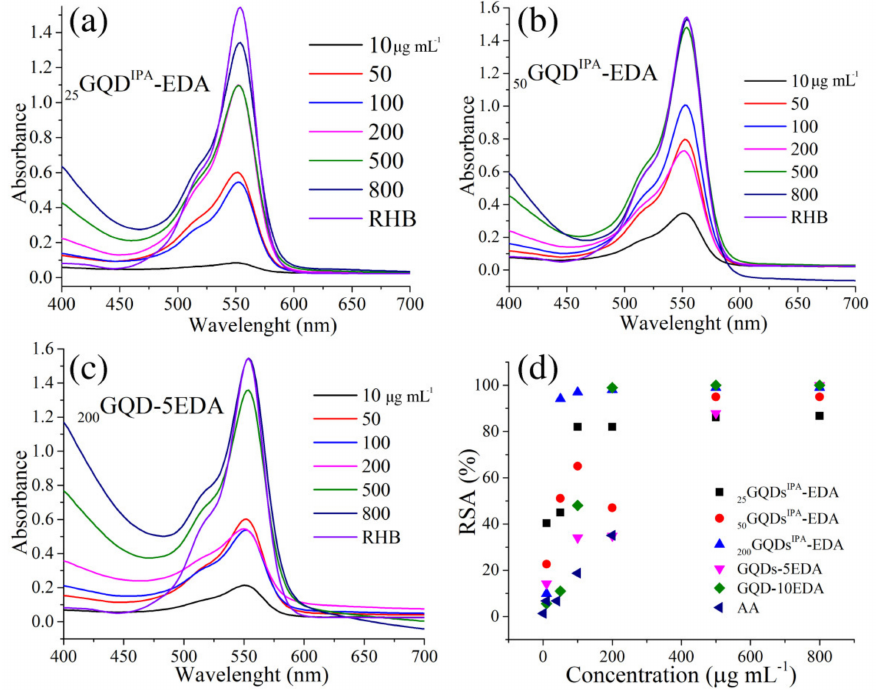
Figure 8. RHB test: 25 GQD IPA -EDA ( a ), 50 GQD IPA -EDA ( b ), 200 GQD-5EDA ( c ), and RSA as a function of GQDs concentration ( d